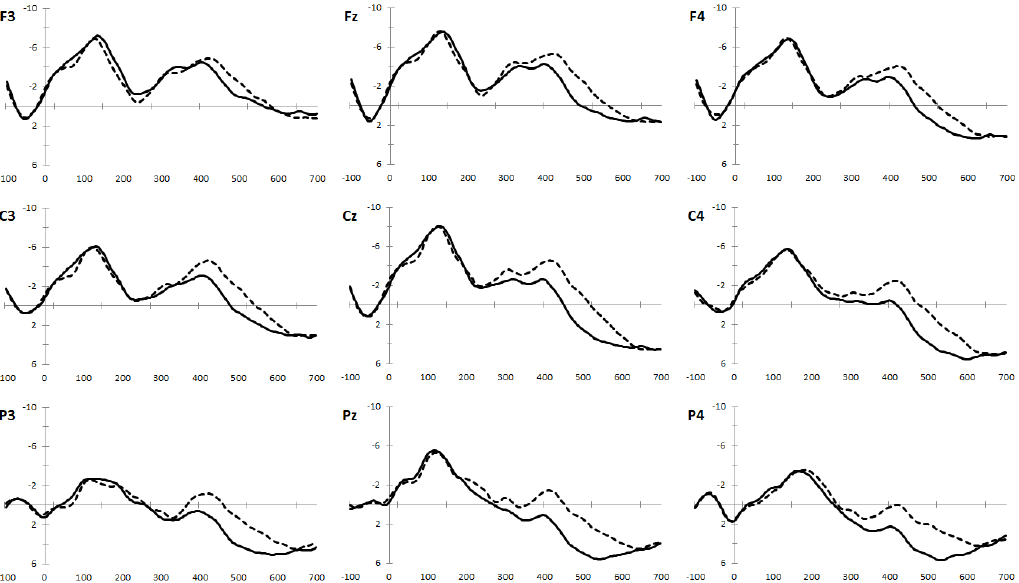
Figure 4. Grand average ERP waveforms for form-unrelated (dotted lines) and form-related words (solid lines) in Experiment 2. ERPs are plotted for nine equidistant representative electrodes within each region of interest. Negative voltage is plotted up. Onset of the Spanish word (i.e., the target) is indicated by the vertical calibration bar. Data are plotted from 100 ms prior to and 700 post stimulus onset.